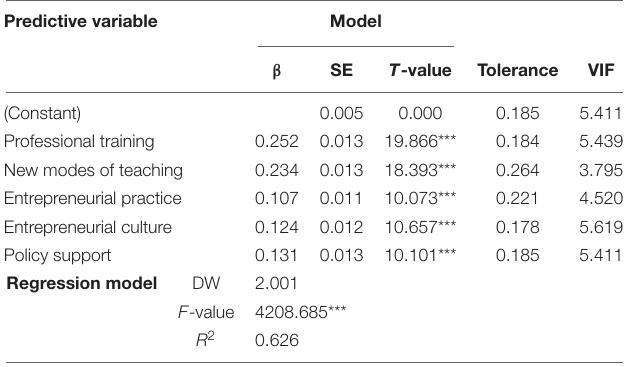
TABLE 5 | Summary of regression analysis of teachers’ total competency in entrepreneurship education. Predictive